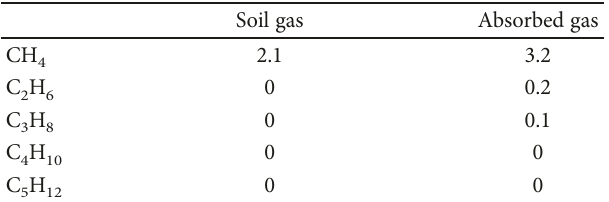
Table 4: Gas concentration analyses of soil gas and absorbed gas in the background